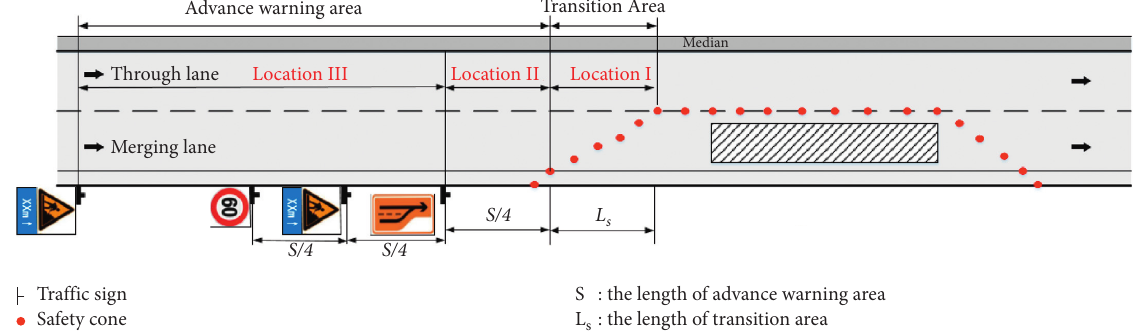
Figure 1: Division of merging areas in freeway work